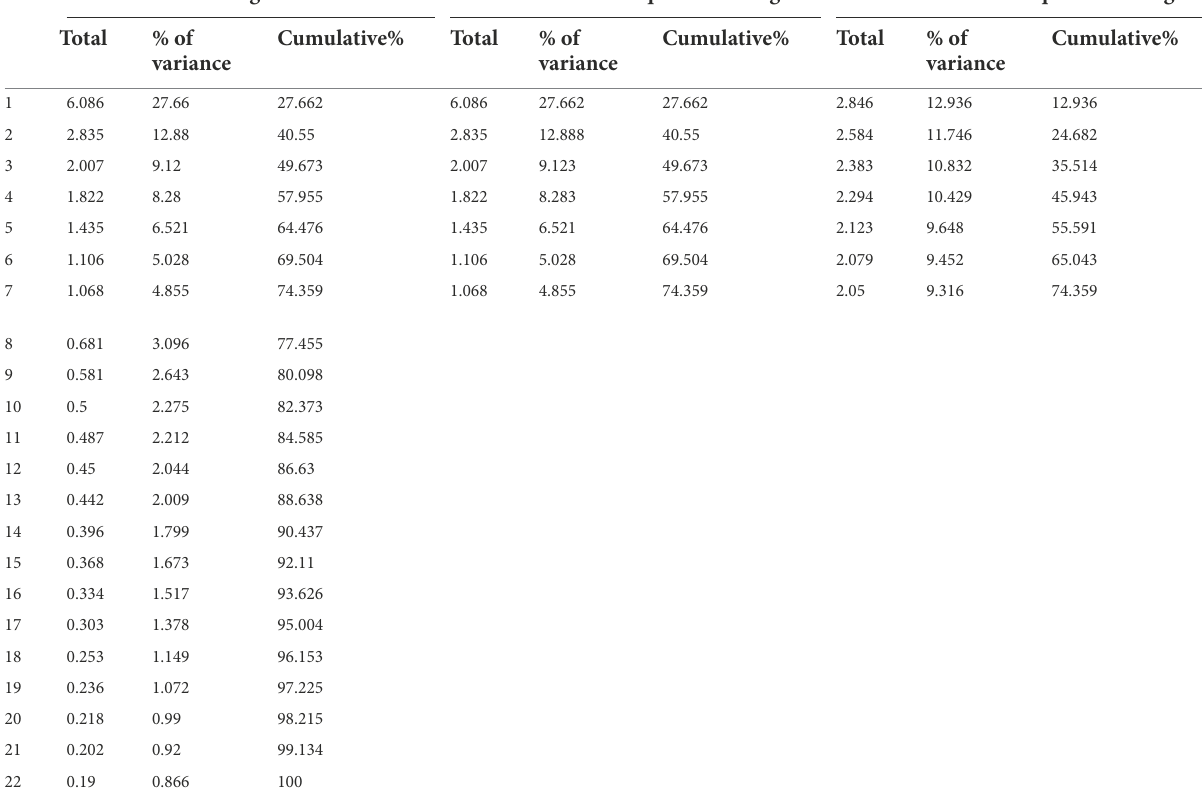
TABLE 2 Total variance of interpretationIngredients. Initial eigenvalue Extract sum of squares